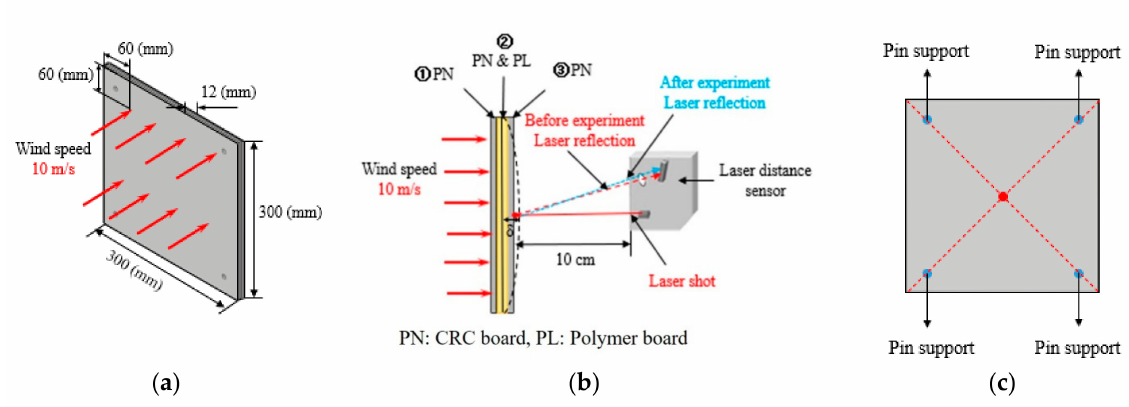
Figure 12. Details of the test specimen setting: ( a ) front view; ( b ) side view; ( c ) rear view.